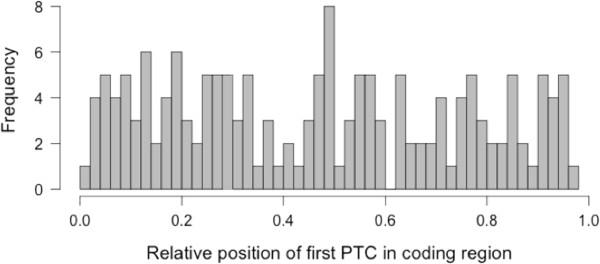
Histogram of the position of the first pre-terminal codon (PTC) within the neo-Y coding sequence, relative to the length of the neo-Y coding region.